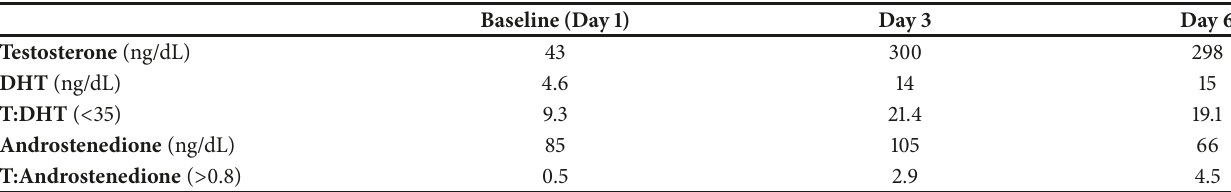
Table 3: hCG stimulation test done at the age of 10 years and 10 months with 5000-unit hCG once a day for 3 days.